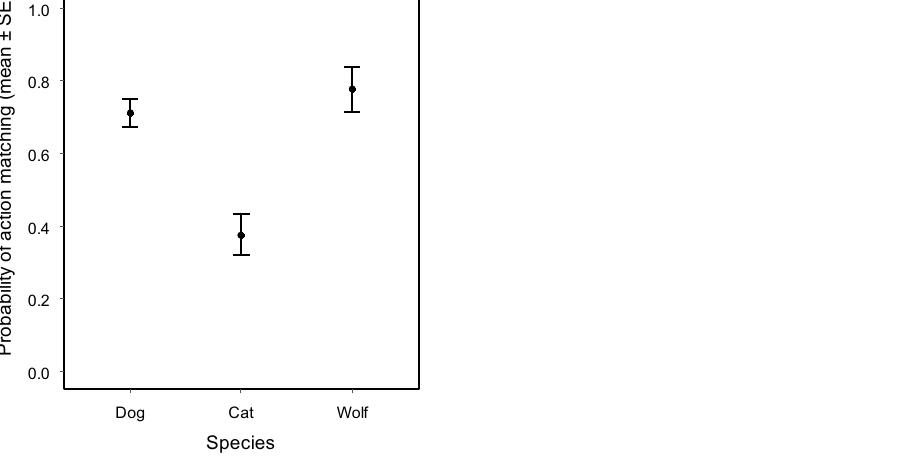
Figure 5. Probability of action matching in dog puppies, kittens and wolf pups. Dog puppies and wolf pups matched their actions to the demonstrated one more often than kittens (GLMM of action matching, effect of species: χ 2 2 = 11.931; P = 0.003; dog puppies → kittens: exp(β) = 0.046 [0.005; 0.431], z = − 2.70, P = 0.007; dog puppies → wolf pups: exp(β) = 1.249 [0.081; 19.324], z = 0.16, P = 0.874).